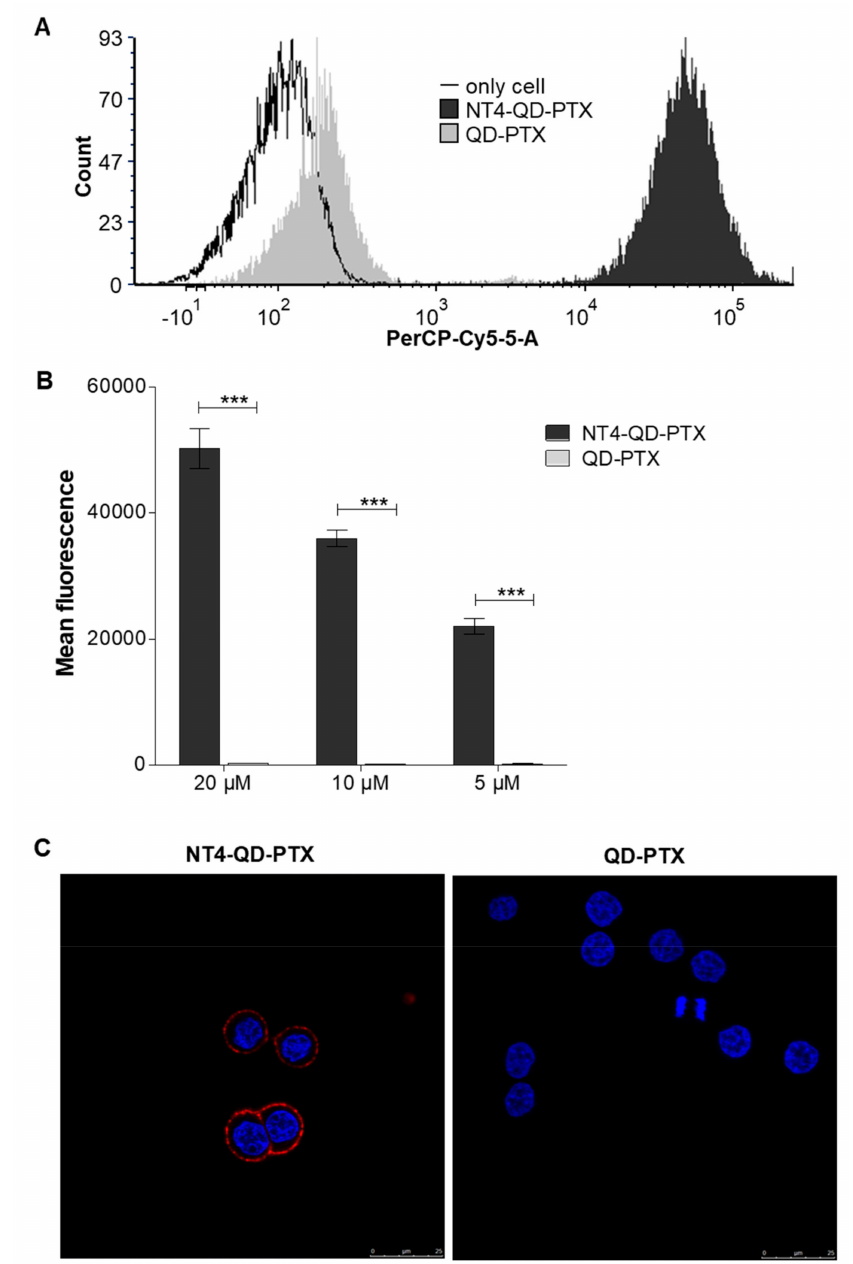
Figure 3. Binding of NT4-QD-PTX and unlabeled QD-PTX to HT-29 cell line by flow cytometry and immunofluorescence. ( A ) Flow cytometry analysis of 20 nM NT4-QD-PTX (dark grey) and unlabeled QD-PTX (light grey) in HT-29 cells. ( B ) Mean fluorescent detected by flow cytometry using scalar concentrations of NT4-QD-PTX and unlabeled QD-PTX. *** p < 0.001 calculated using one-tailed Student t-test and Graph Pad Prism software. ( C ) Immunofluorescence of NT4-QD-PTX (red signal) in HT-29 cell line. Nuclei were stained with DAPI (blue signal). Scale bar 25 µ